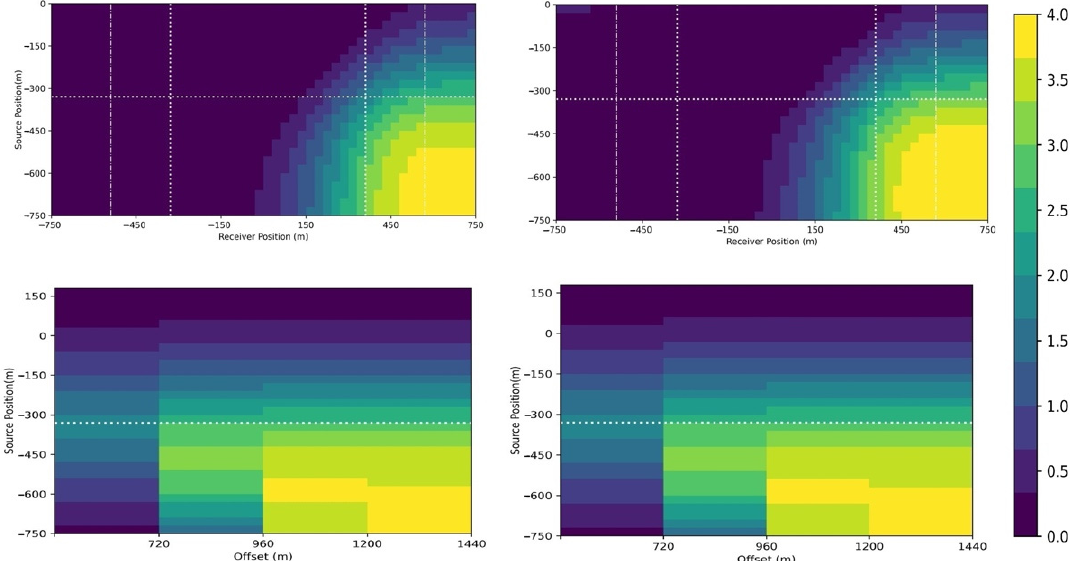
Figure 8. The NAD in the inline electric fields with and without the reservoir for the stationary (top row) and moving (bottom row) receiver configurations and with the source 50 m above (left column) and on (right column) the seafloor. The x -axis is the position of receiver or the offset, and the y -axis is the source position. Because the geometry was symmetric, we only show the source positions from − 750 m to 0 m in the top row, while we show it for the source up to 150 m in the bottom row. The white dotted lines indicate the edges of the reservoir in receiver position (vertical lines) and source position (horizontal line). The white dash-dotted lines indicate the horizontal locations one burial depth away from the edges of the reservoir. The red line indicates the first offset (720 m) in the moving receiver configurations. The white solid line marks the 0.25 contour. The red line shown the fixed offset acquisition position.